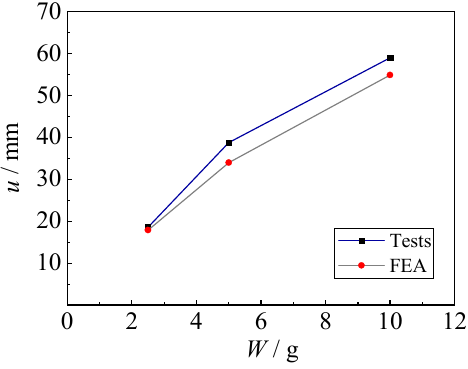
Figure 14. Comparison of maximum deformation between tests and FEA.